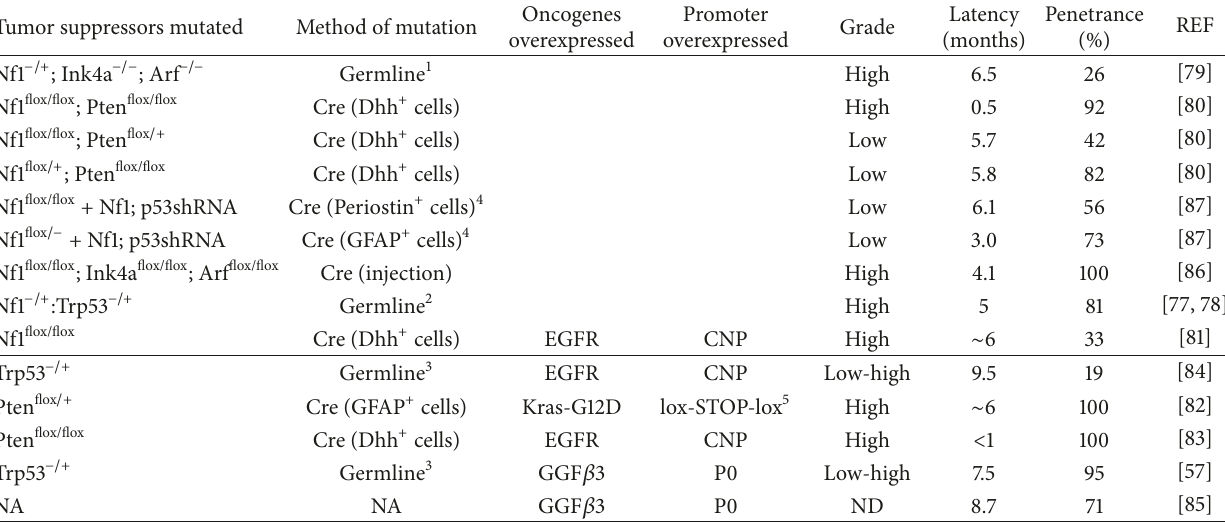
Table 2: Genetically engineered mouse models